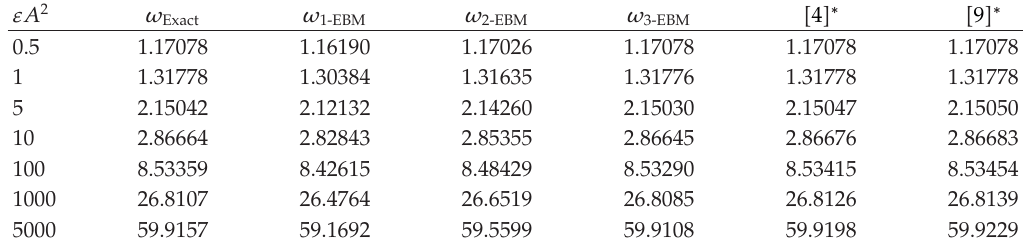
Table 1: Comparison of the first-, second-, and third-order frequencies for α (cid:9) 1 and λ (cid:9)